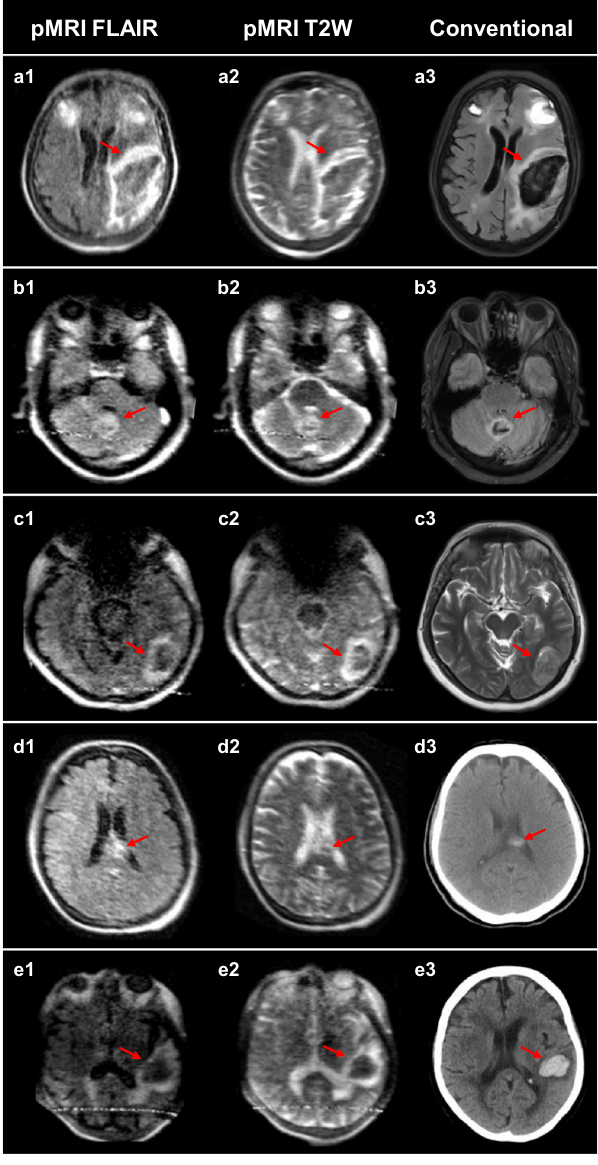
Fig. 2 Intracerebral hemorrhage at 0.064T versus conventional imaging modalities (CT or 3T MRI). The fi rst and second columns are low- fi eld FLAIR and T2W images, respectively. The third column is a gold-standard clinical examination for comparison (3T MRI: a 3, b 3, c 3, and e 3; CT: d 3). a Left isointense fronto-parietal intracerebral hemorrhage (ICH) with hyperintense rim and bilateral frontal hematomas. b Bilateral isointense cerebellar ICH with hyperintense rim. c Left hypointense occipital lobe ICH with hyperintense rim. d Left homogenous, hyperintense ICH in corpus collosum. e Left hypointense temporal ICH with hyperintense rim. plots showed a bias of − 1.70 cc [95% CI: − 3.45 – 0.0470] with limits of agreement from − 11.8 cc [95% CI: − 14.8 – 8.81] to 8.42 cc [95% CI: 5.409 – 11.4] for pMRI T2W sequences (Fig. 4a2) and a bias of − 1.22 cc [95% CI: − 4.51 – 2.07] with limits of agreement from − 20.8 cc [95% CI: − 26.5 to − 15.2] to 18.4 cc [95% CI: 12.7 – 24.1] for pMRI FLAIR sequences (Fig. 4a3). Hematoma volumes estimated by the ABC/2 method were averaged across raters and strongly correlated with averaged conventional imaging volumes (T2W: ICC = 0.917, 95% CI: [0.814 – 0.96], p = 1.58e-8; FLAIR: ICC = 0.857, 95% CI: [0.665 – 0.932], p = 9.46e-6; T2W and FLAIR: ICC = 0.875, 95%